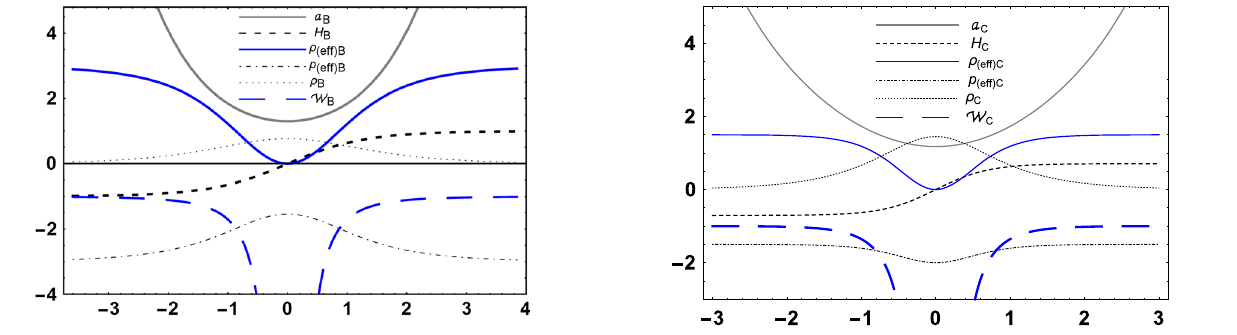
Fig. 4 Cosmological parameters of the bouncing solution for the model B . We have set α = 20, (cid:14) B = − 0 . 3 and ρ 0 = 1